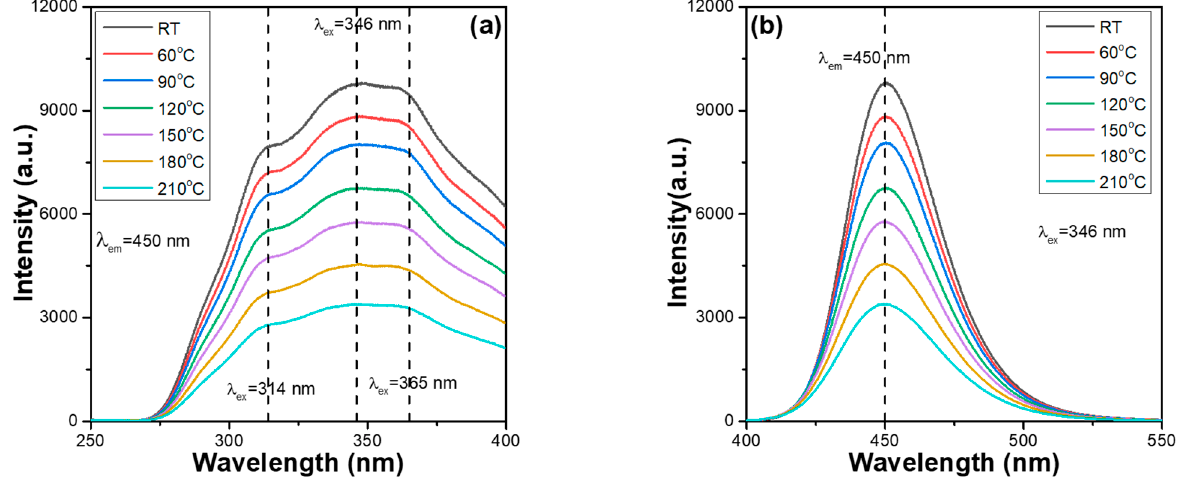
Figure 3. Temperature-dependent ( a ) PLE and ( b ) PL spectra of Ca 0 . 75 Mg 1 . 25 Si 2 O 6 :0.025Eu 2+ phosphor.